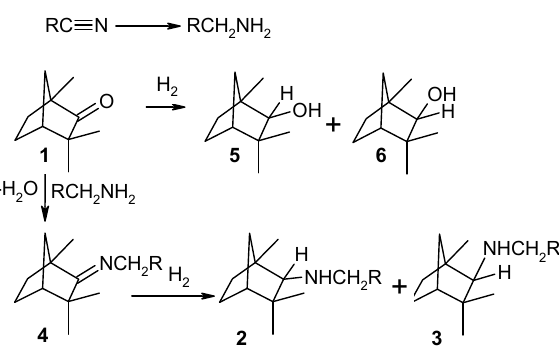
Figure 6. Scheme of reductive amination of D-fenchone ( 1 ) by aliphatic nitriles to prepare fenchylamine. Adapted from [67].